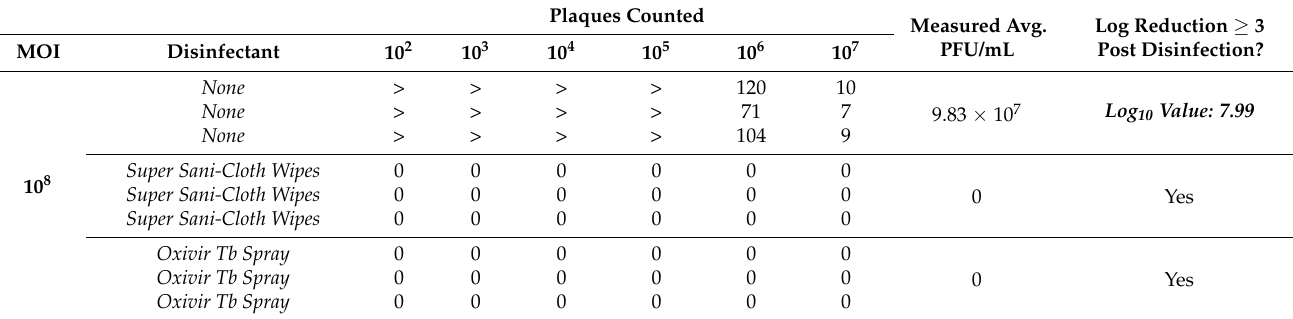
Table 2. Disinfection data for VSV-GFP 100 µ L spot on laminate wood. Plaques